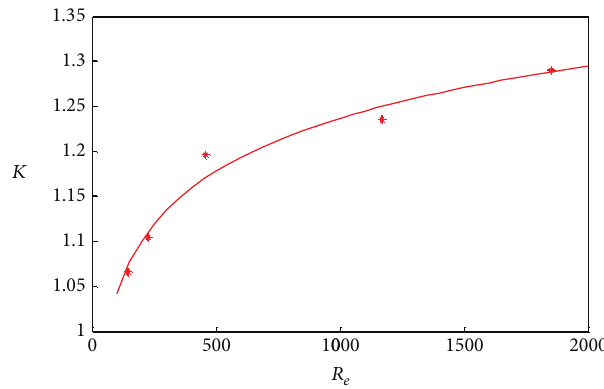
Figure 12: The relationship of power factor 𝐾 and 𝑅 𝑒 .